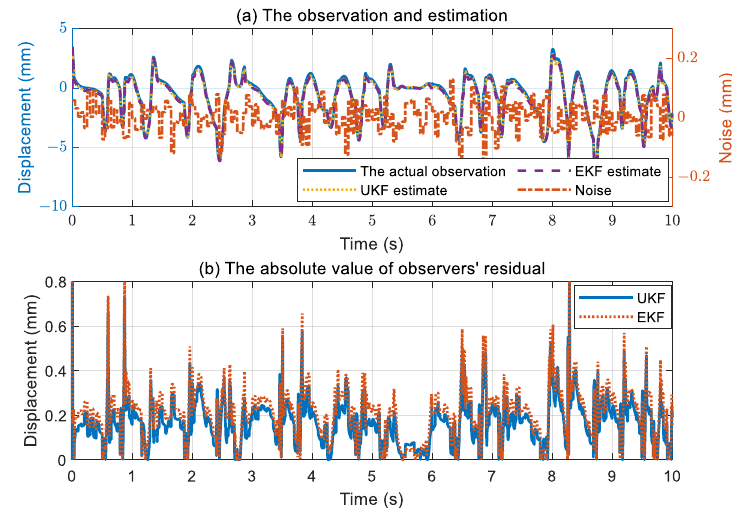
Figure 14. The measurement and its residual in closed-loop test.